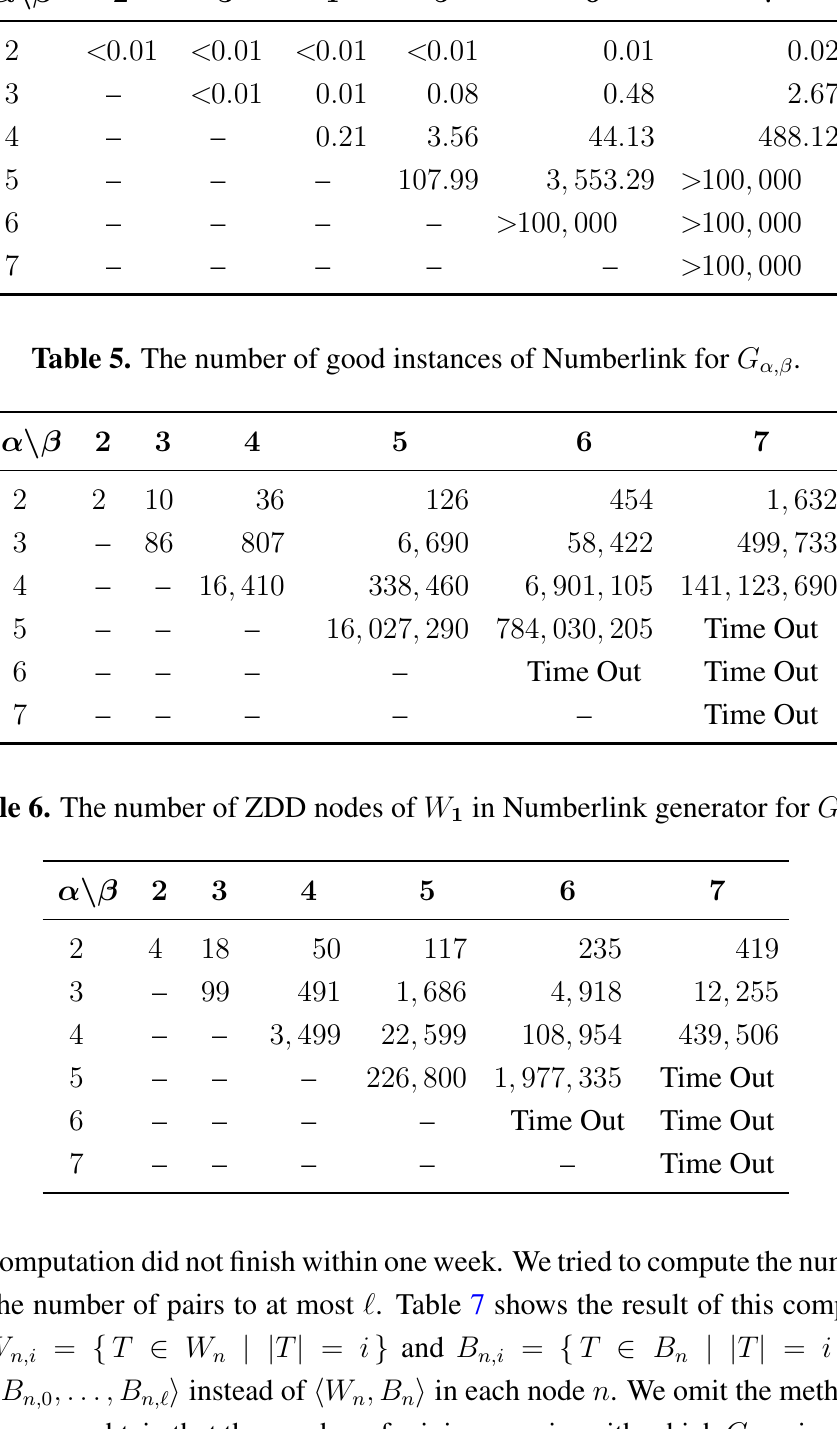
Table 4. Running time of Numberlink generator for G